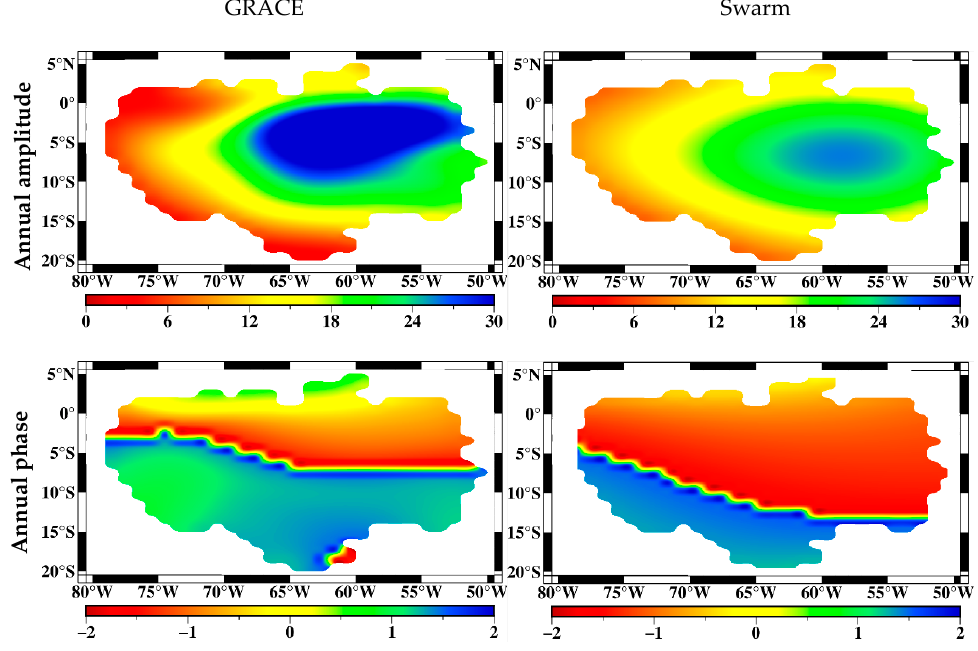
Figure.10 TWSC seasonal changes in the Amazon River basin calculated by GRACE and Swarm. Figure 10. TWSC seasonal changes in the Amazon River basin calculated by GRACE and